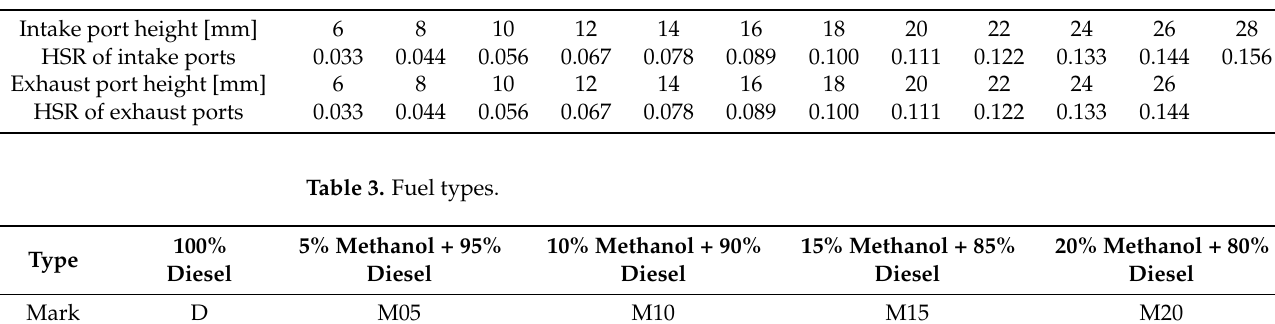
Table 3. Fuel types. Table 4. Fuel